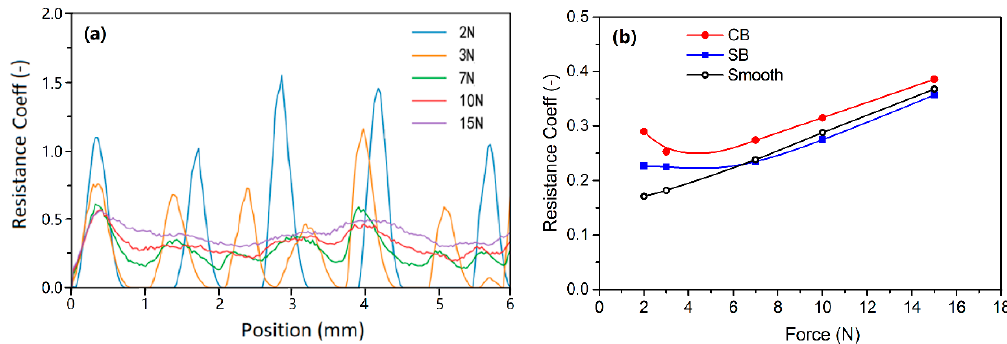
Figure 7. ( a ) Instantaneous resistance coefficient in scratching and ( b ) scratch resistance coefficients of different surfaces.